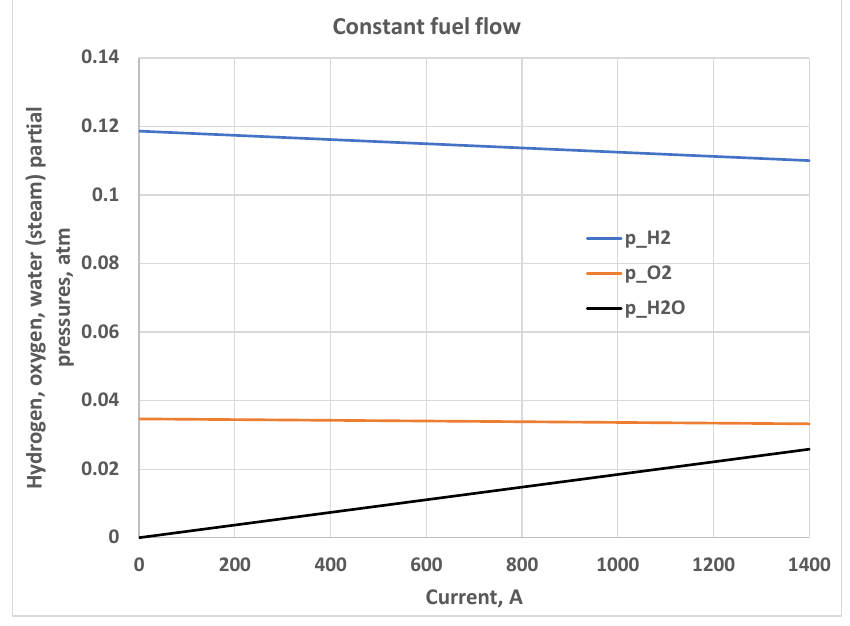
Figure 6. Linear dependence of the three partial pressures upon current (hydrogen and oxygen input flow rates are held